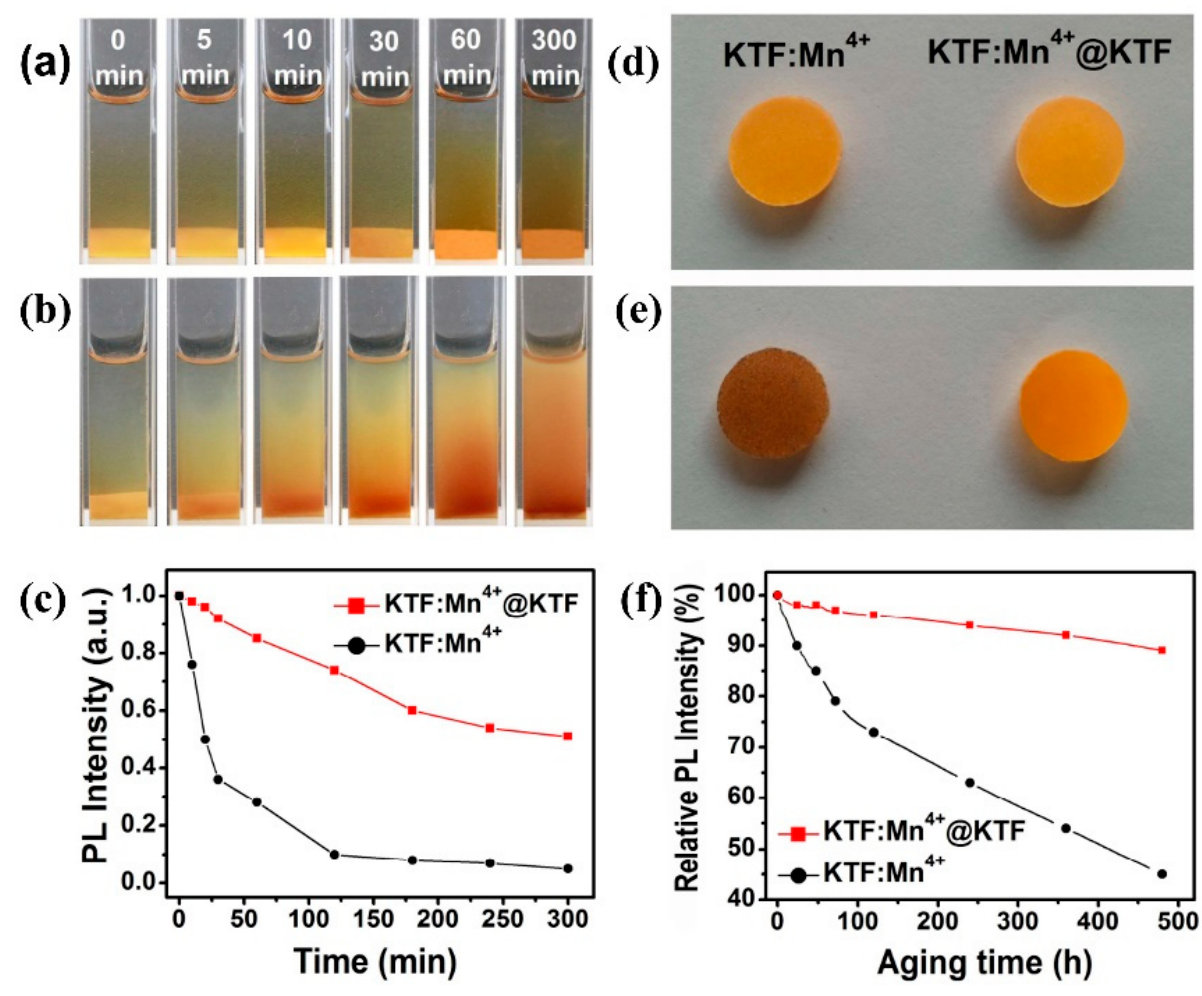
Figure 17. ( a ) Photographs of KTF: Mn 4+ @KTF and ( b ) KTF: Mn 4+ phosphors soaked for different times; ( c ) comprehensive PL intensities of KTF: Mn 4+ @KTF and KTF: Mn 4+ soaked for different times; ( d ) before and ( e ) after the phosphors aged under HT and HH conditions photographs; ( f ) compre- hensive PL intensity of the phosphors aging at different times. (Reprinted from Ref [28]. Copyright from John Wiley and Sons Ltd., 2019.).